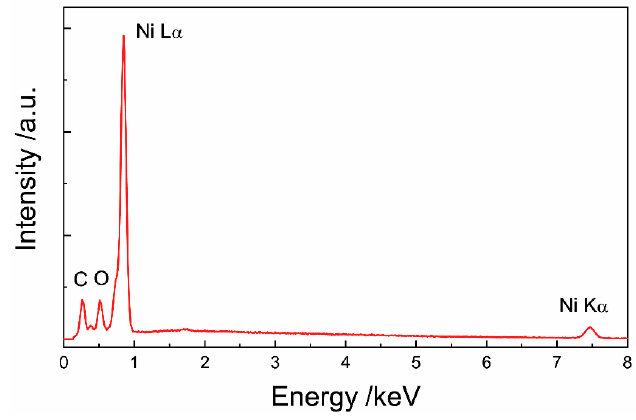
Figure 3. EDS spectrum of printed and sintered Ni MOD ink.